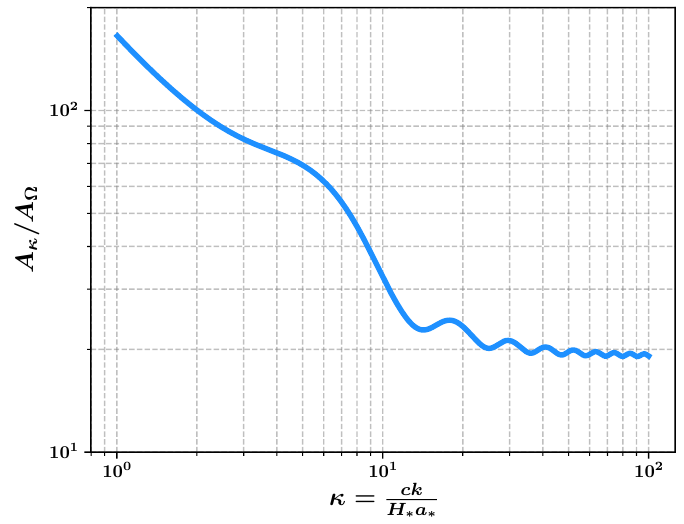
Figure 14: Ratio between the amplitudes in Eqs. (C.9) and (C.10) evaluated at t for a benchamark strong PT with α → ∞ , r β = 1 and t ∗ = 10 10 s. Note that the ratio is always bigger than 20, meaning that the solution sourced by the decaying GW source after t can be safely neglected in Eq. f